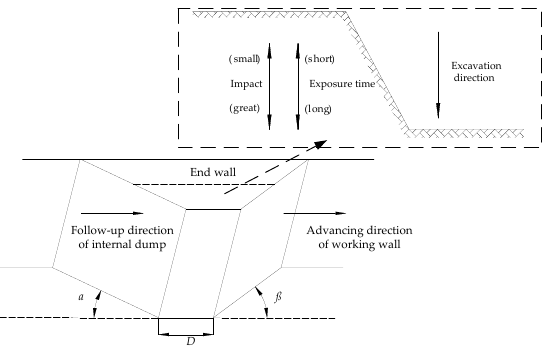
Figure 8. Timeliness difference of mechanical properties of slope in space.